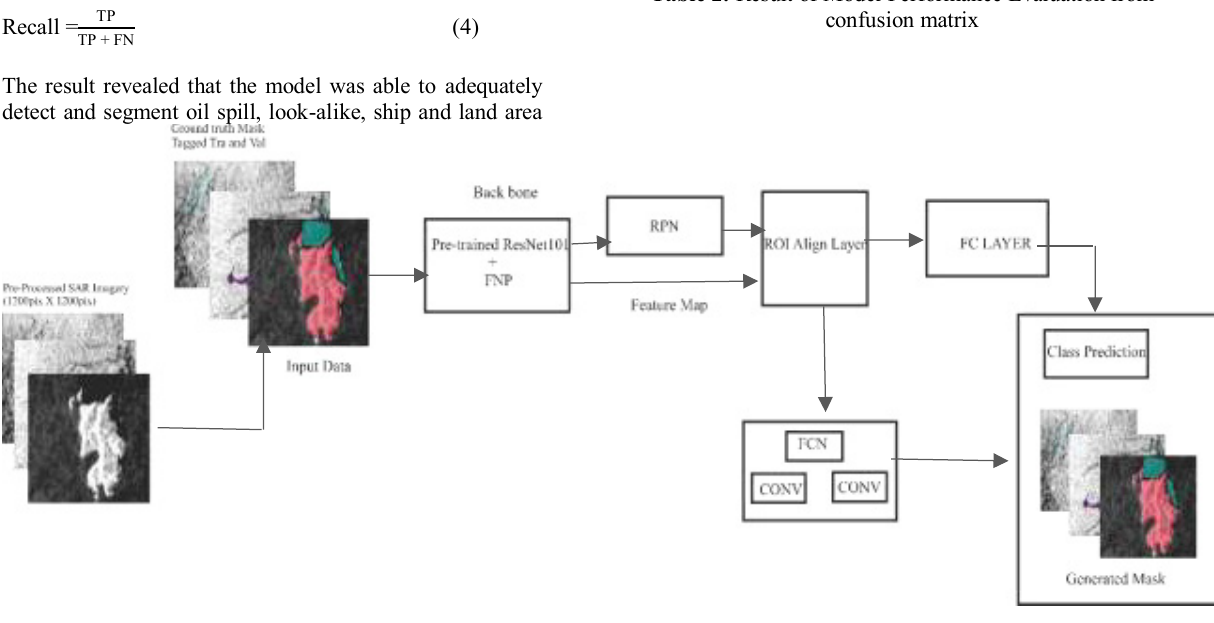
Table 2: Result of Model Performance Evaluation from